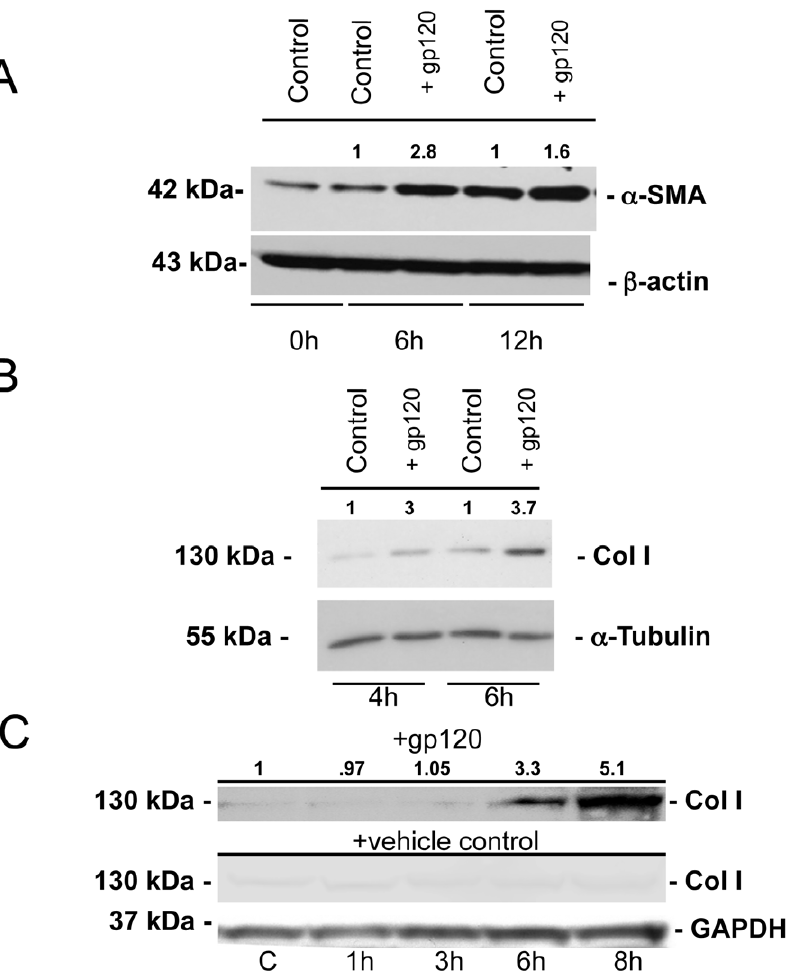
Figure 2. X4 HIV-1 gp120 promotes a-SMA and collagen I protein expression in human HSCs. (A, B) LX-2 cells were incubated with 500 ng/ml X4 gp120 for 0–12 hours, protein harvested, and expression of a-SMA and collagen I examined by Western blot analysis. (C) The effect of X4 gp120 versus vehicle control on collagen I protein expression was further confirmed in passage # 3 primary HSCs. Densitometry was performed and normalized arbitrary units represented numerically.